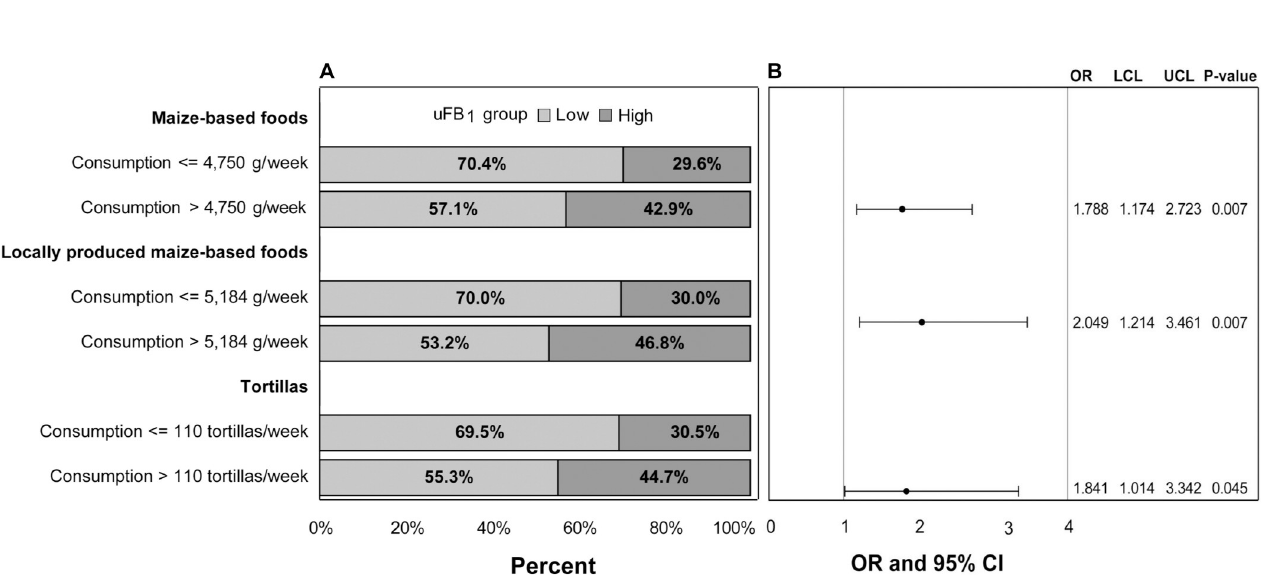
Fig 6. A Significant maize-based food groups and foods associated with low ( < 0.5 ng/ml) or high ( � 0.5 ng/ml) uFB 1 groups in categorical analysis. ( B ) Odds ratios (OR), upper (UCL) and lower (LCL) 95% confidence levels, and p-values from logistic regression.